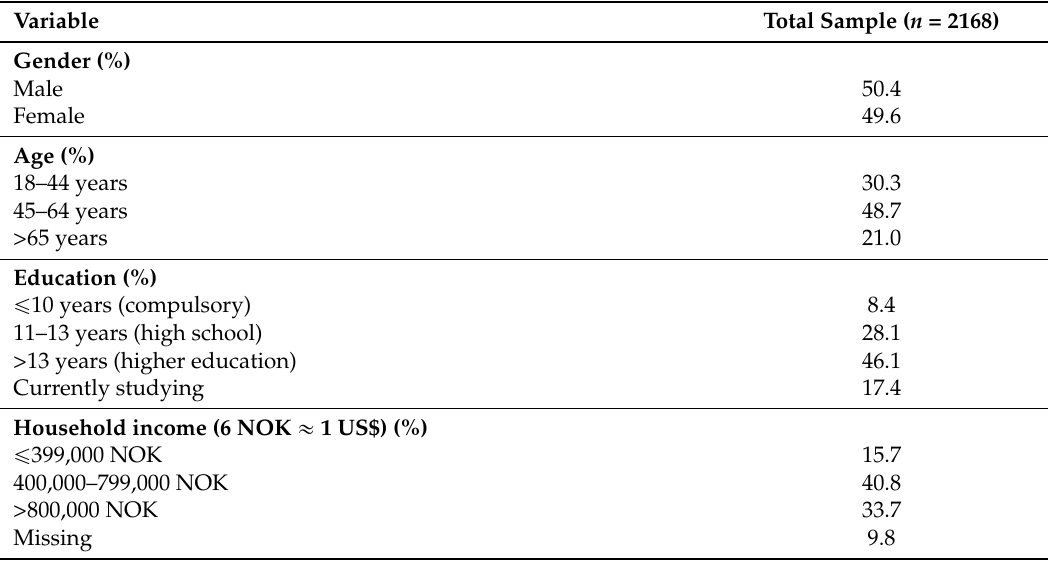
Table 1. Background information and physical activity levels in a sample of 2168 Norwegian